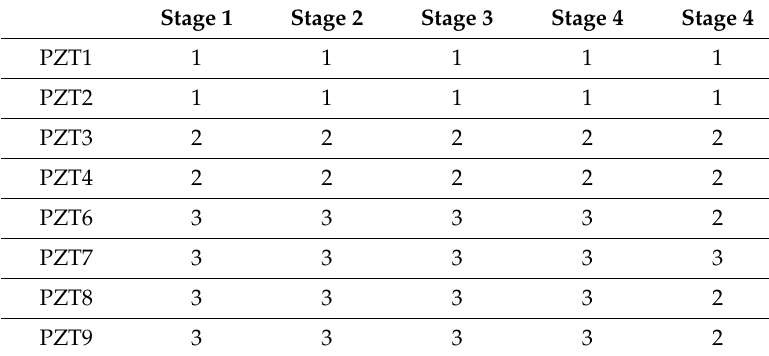
Table 2. K-means clustering results—beam B.